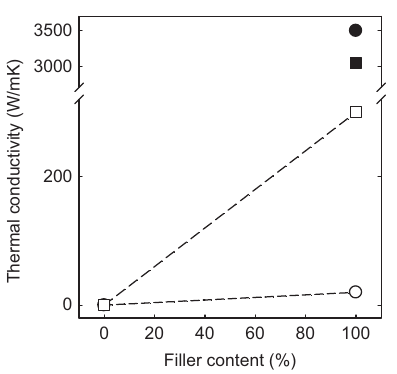
Figure 7 An illustration on the thermal transport properties (ther- mal diffusivity) of individual carbon nanotubes ( (cid:2) ) and graphene pieces ( (cid:3) ), and their corresponding bulk materials ( (cid:4) and (cid:5) , respec- tively) and polymeric nanocomposites (dashed lines).